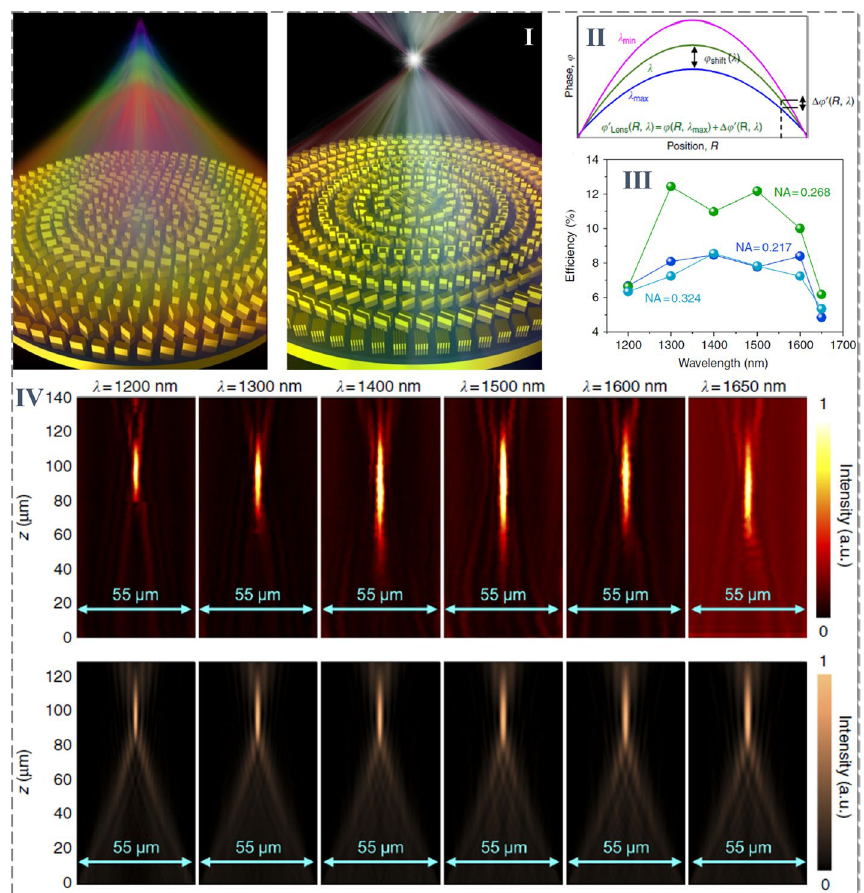
Fig. 8 Schematic of chromatic (left side of (I)) and achromatic (right side of (I)) meta-lens. (II) Phase profile of a broadband achromatic meta-lens at an arbitrary wavelength. (III) Operation efficiency at the corresponding focal plane as a function of wavelength. (IV) Experimental (top row) and numerical (bottom row) intensity profiles of broadband achromatic meta-lens along axial planes. Reproduced with permission [201]. Copyright 2018,